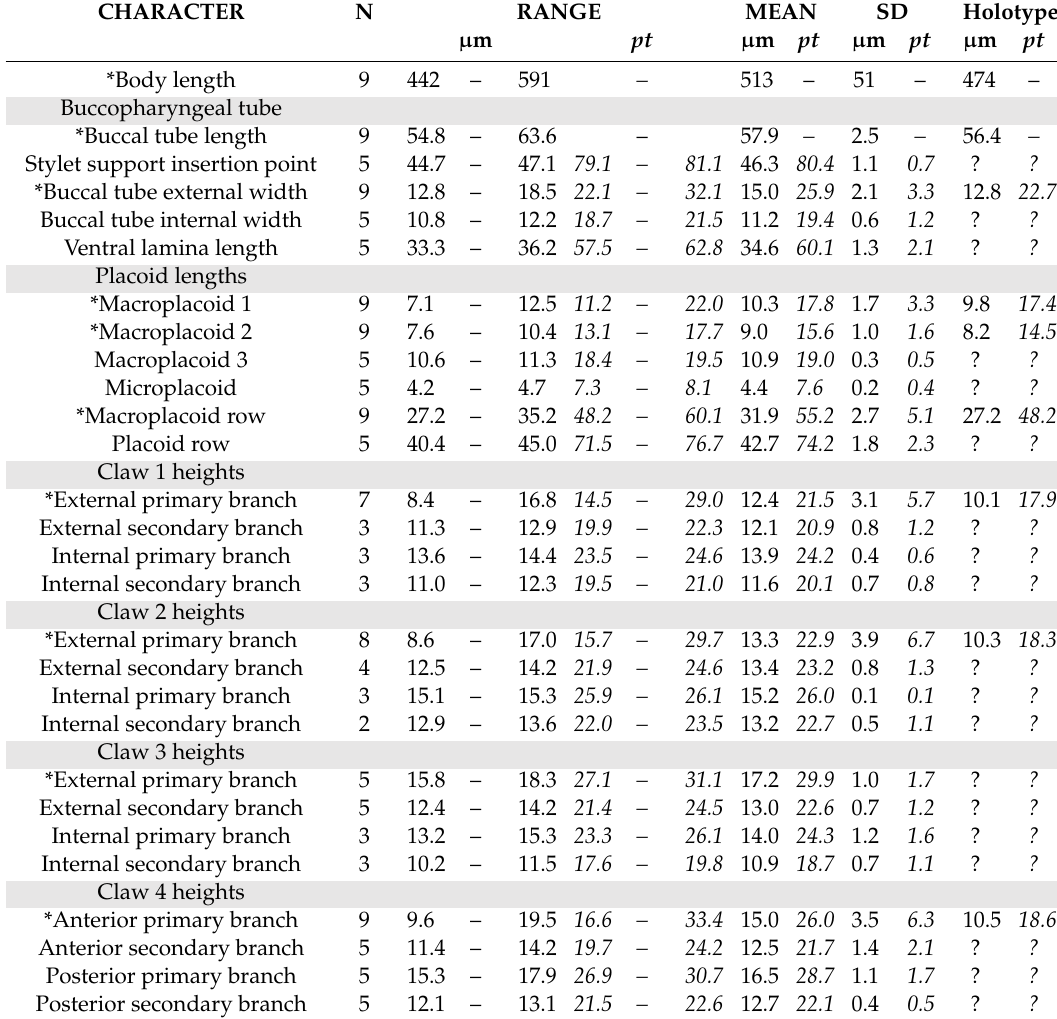
Table 7. Measurements (in µ m) and pt values of selected morphological structures of individuals of the American (Alaskan) population of Paramacrobiotus fairbanksi Schill, Förster, Dandekar and Wolf [25] mounted in Hoyer’s medium (N, number of specimens / structures measured; RANGE refers to the smallest and the largest structure among all measured specimens; SD, standard deviation, pt , ratio of the length of a given structure to the length of the buccal tube expressed as a percentage). * measurement based partially on Schill et al.